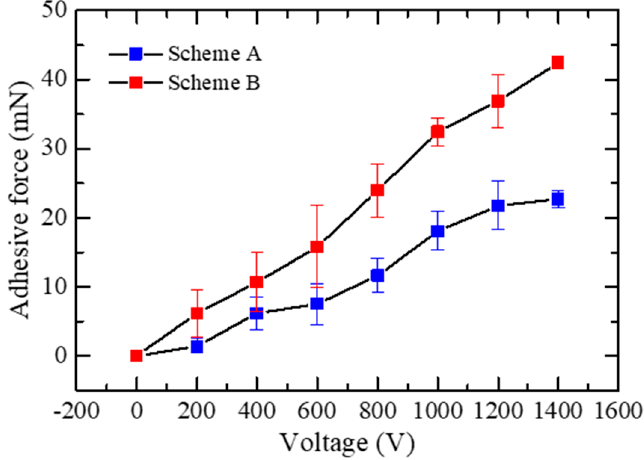
Figure 6. Generated adhesive forces of different wiring schemes.